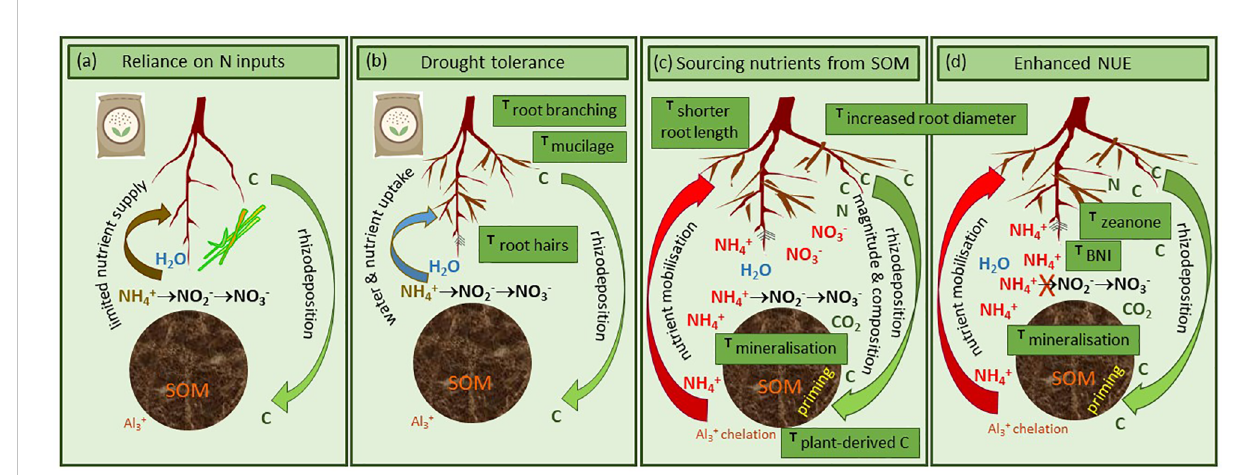
FIGURE 2 Theoretical representation of processes and associated traits of different maize genotypes exhibiting (A) reliance on mineral and organic inputs to alleviate nutrient limitation, (B) drought tolerance for enhanced water and nutrient uptake, (C) ability to source nutrients released from priming of soil organic matter (SOM), and (D) ability to enhance biological nitri fi cation inhibition (BNI) to retain these SOM-derived nutrients. T indicates the maize traits we highlight in our text as potential targets for